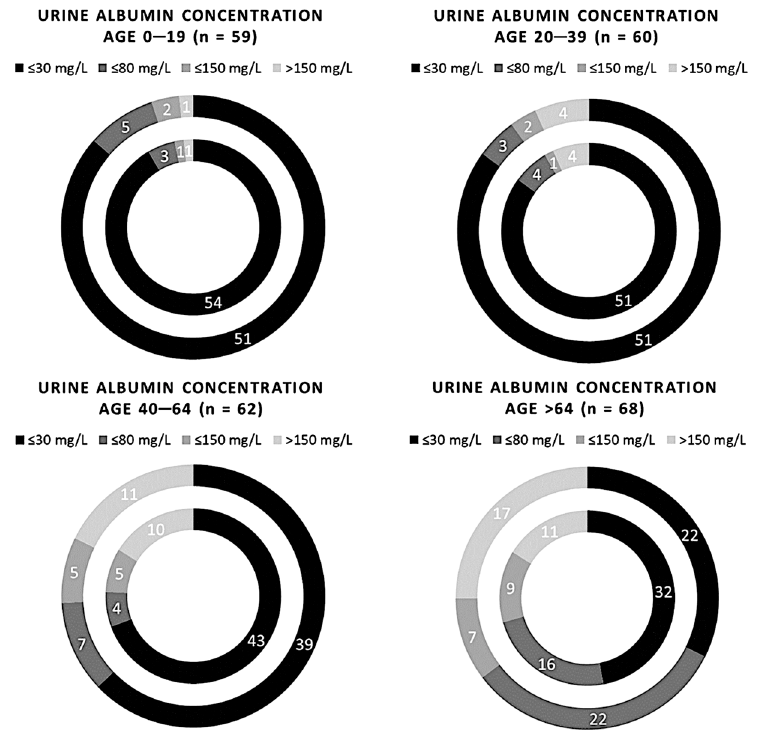
Figure 3. Comparison of 249 samples of albuminuria measured using the semi-quantitative and quantitative methods, redistributed on age. The inner circle represents the Cobas C 501 assay results, and the outer circle indicates the results of the Sysmex UC 3500.